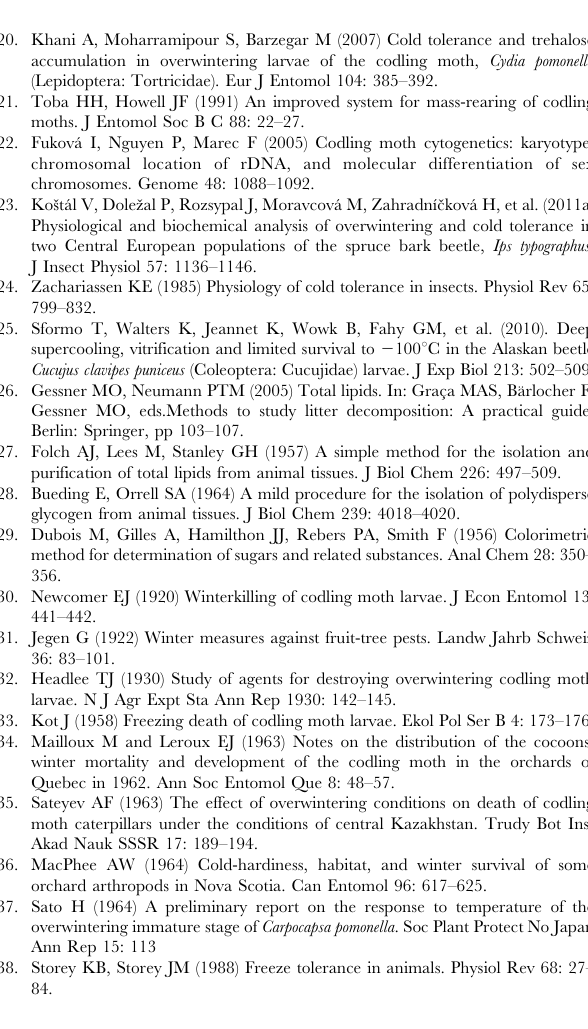
Figure S1 Course of ambient temperatures in two overwintering microhabitats, tree trunk and litter layer, of the caterpillars of Cydia pomonella during 2010/2011. (DOCX) Figure S2 PCA analysis of metabolomic changes in the fat body of field-sampled caterpillars of Cydia pomo- nella . (DOCX) Figure S3 PCA analysis of metabolomic changes in the body wall of field-sampled caterpillars of Cydia pomo- nella .